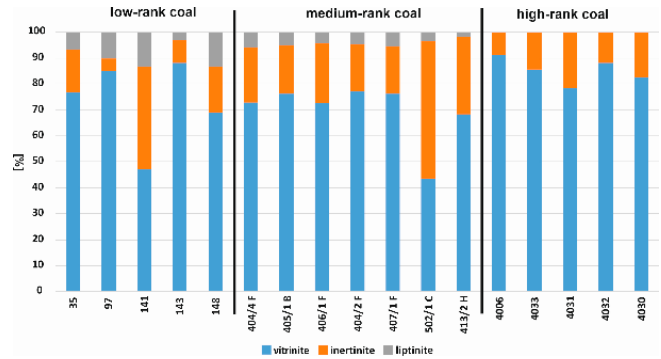
Figure 3. Share of main maceral groups in samples of various metamorphism degree (recalculated to mineral matter-free (mmf)).